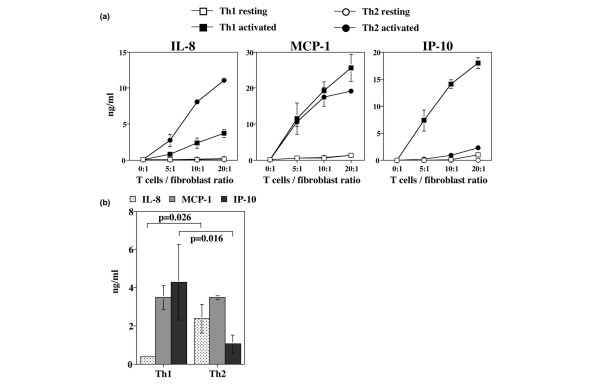
IL-8, MCP-1 and IP-10 production by dermal fibroblasts following contact with T-helper cells. Normal fibroblasts were plated at 2 × 104 cells/well; 72 hours later the culture medium was replaced and T cell membranes generated from resting or activated Th1 and Th2 clones were added to the wells to a final volume of 200 μl. Chemokine levels were determined in the supernatants by enzyme-linked immunosorbent assay after 48 hours of further culture. (a) The points represent the mean ± standard deviation of triplicate cultures. Similar results were obtained in an additional experiment. (b) T cell membranes corresponding to 2 × 105 cells generated from activated Th1 (n = 10) and Th2 (n = 10) clones were added to the wells in triplicate cultures. The bars represent the mean ± standard error. IL, interleukin; IP, interferon-γ inducible protein; MCP, monocyte chemoattractant protein; Th, T-helper.